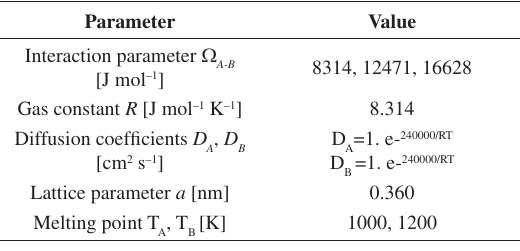
Figure 1. Plot of free energy f, vs. composition c . Table 1. Values of parameters for simulation.